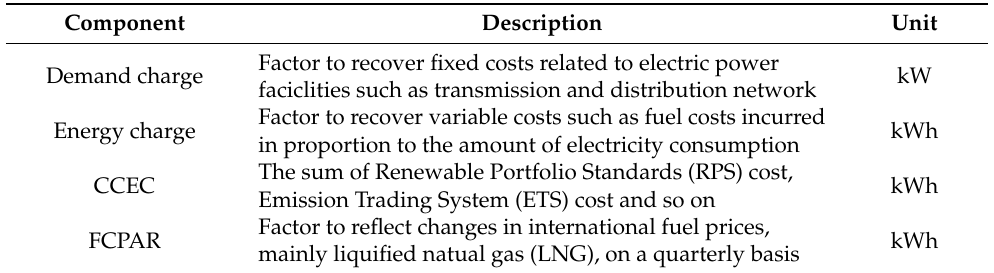
Table 1. Overview of Korea’s electricity bill